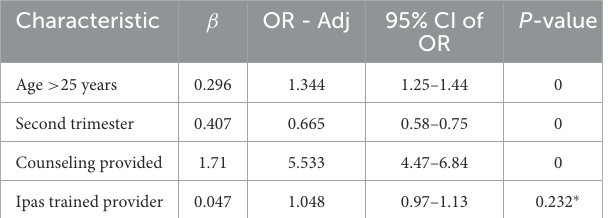
TABLE 4 Logistic regression model for the uptake of post-abortion